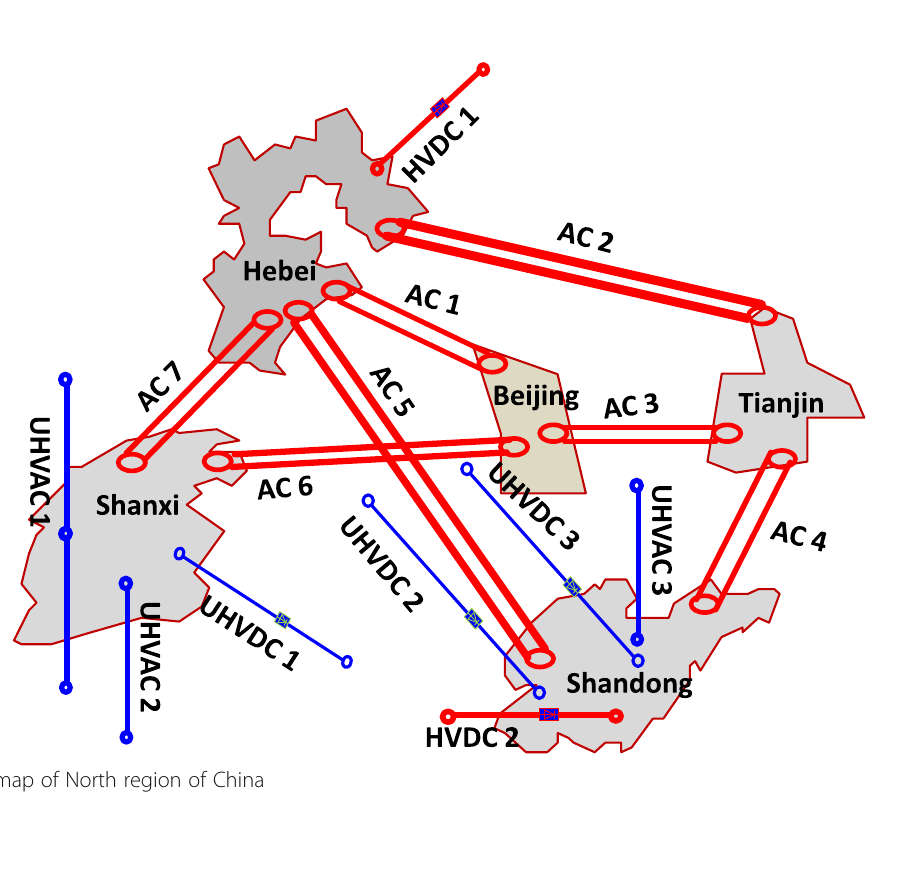
Fig. 5 Tie-lines map of North region of China